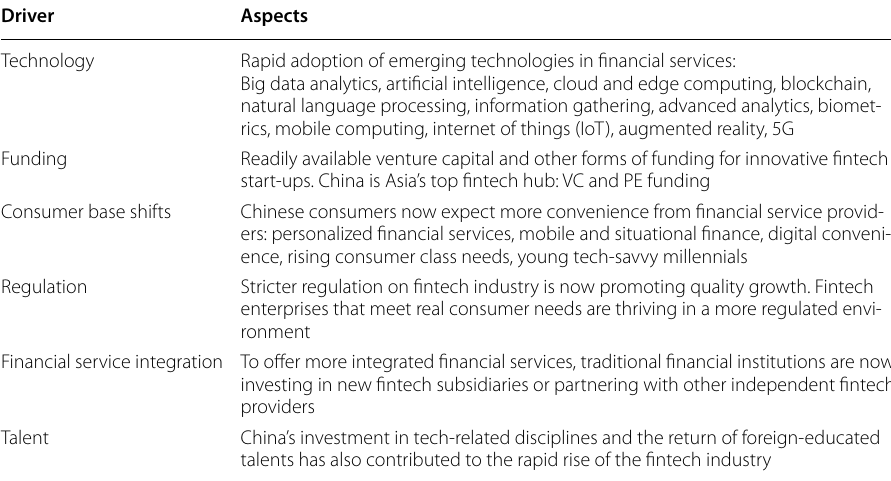
Table 1 Drivers of fintech sector growth. Source: Authors’ compilation Driver